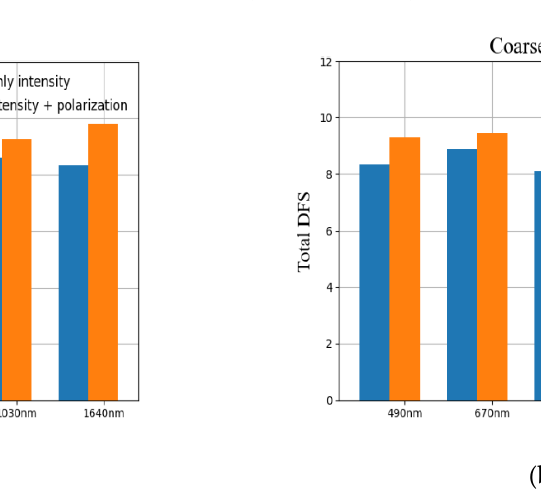
Figure 7. The content of information analysis for different bands, corresponding to fine-dominated aerosol ( a ) and coarse-dominated aerosol ( b ). The ordinate represents the degrees of freedom for signal (DFS), indicating the content of information.